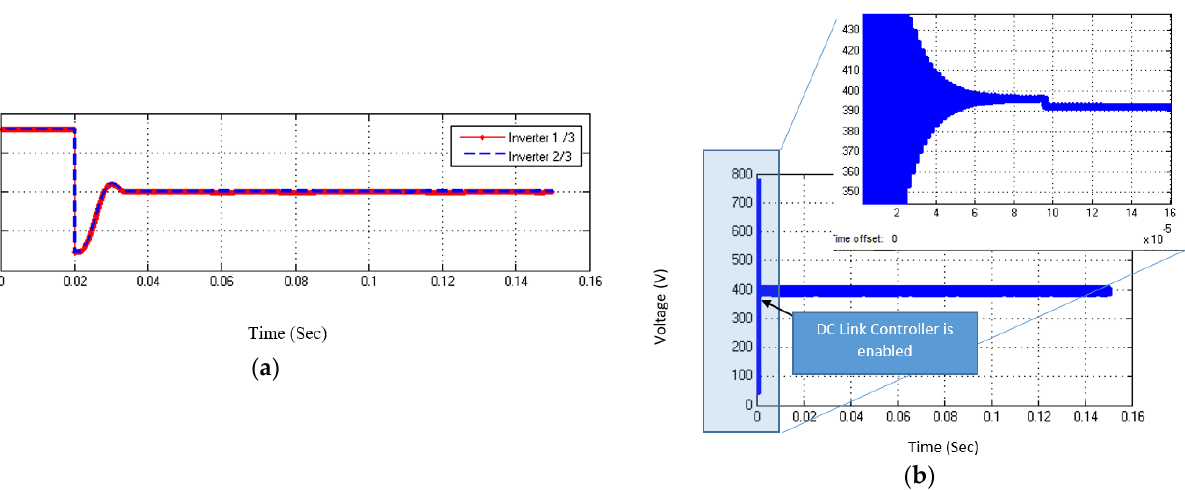
Figure 17. ( a ) Active power of both inverters at P L = 0. ( b ) DC link voltage of inverter with the DC link controller.